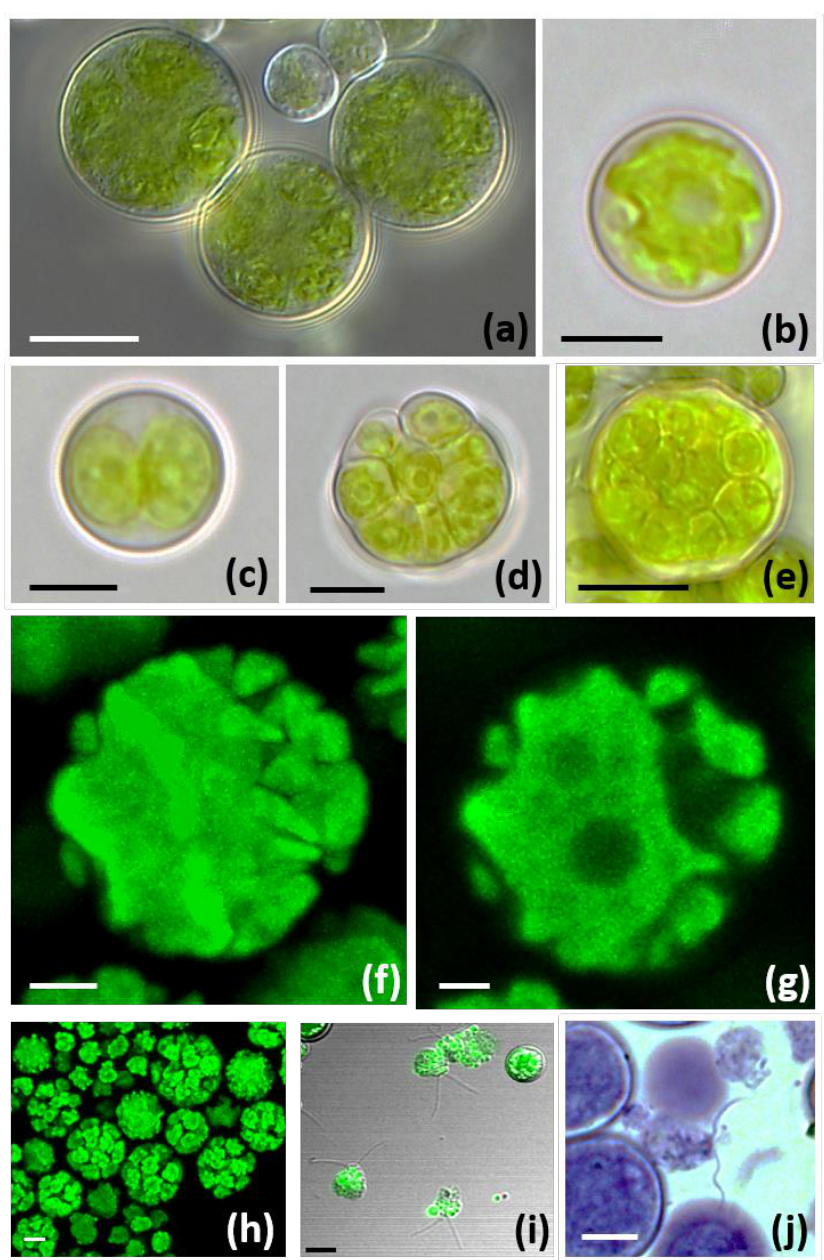
Figure 1. The morphology of Trebouxia lynnae sp. nov.: ( a ) Image composition of T. lynnae cells using differential interference contrast microscopy; ( b ) light micrographs (LM) of mature vegetative cell, and ( c – e ) autosporangia containing different number of autospores; ( f , g ) confocal microscopy reconstructions of the mature chloroplast with shallow, elongated lobes and ( h ) several autosporangia. ( i , j ) Zoospores. Scale bars: ( a – e , j ) = 10 μm, ( f – h ) = 5 μm, ( i ) = 2 0 μm. Reference strain: ASUV 44 .